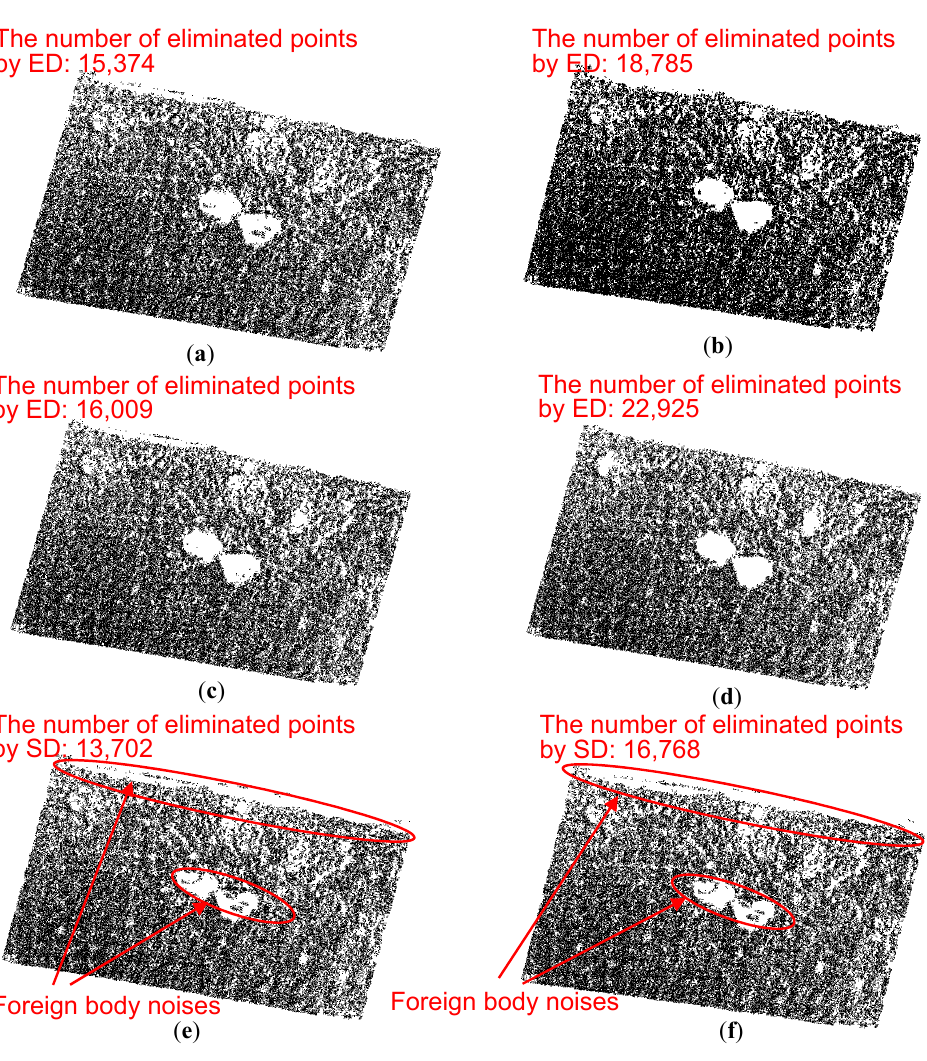
Figure 9. The denoising results of the flat concrete pavement by using ( a ) No. 1, ( b ) No. 2, ( c ) No. 3, ( d ) No. 4, ( e ) No. 5 and ( f ) No. 6 parameter values in Table 4, respectively. (ED: ellipsoid detection; SD: spherical detection) Table 4. The denoising results of the concrete pavement point cloud with stone and kerb noise points by different denoising parameters.